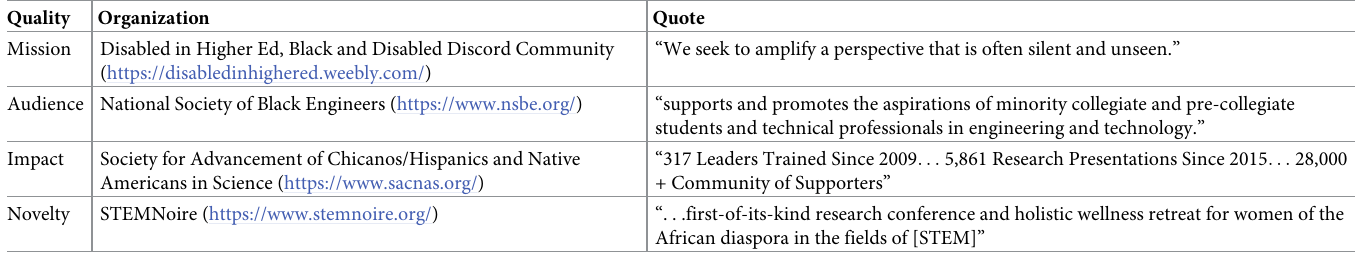
Table 1. Key professional networks and organizations considered in developing the BWCB